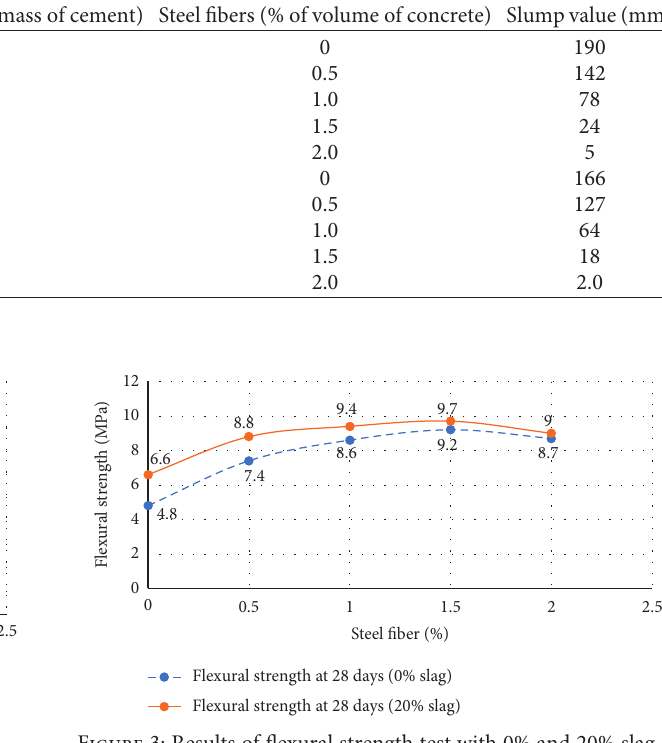
Figure 2: Slump results at different fiber concentrations, with 0% and 20% slag.